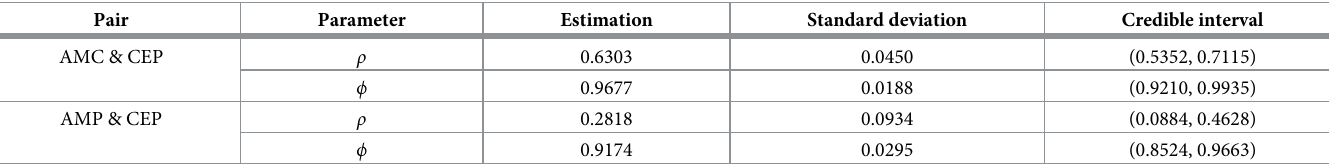
Table 2. Estimations of the correlation in the latent log 2 MIC ( ρ ) and correlation in susceptibility classification ( ϕ ) using Salmonella heidelberg isolates of NARMS human population tested by AMC & CEP and AMP & CEP during 1996-2003.